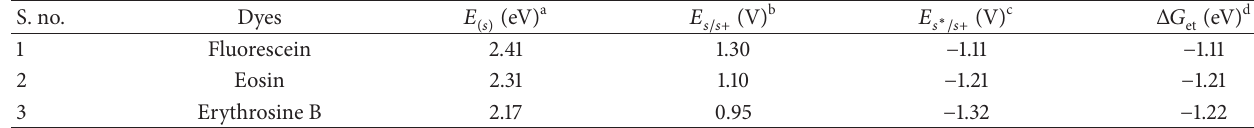
Scheme 3: Proposed electron transfer mechanism. Table 2: Photophysical properties of xanthene dyes.